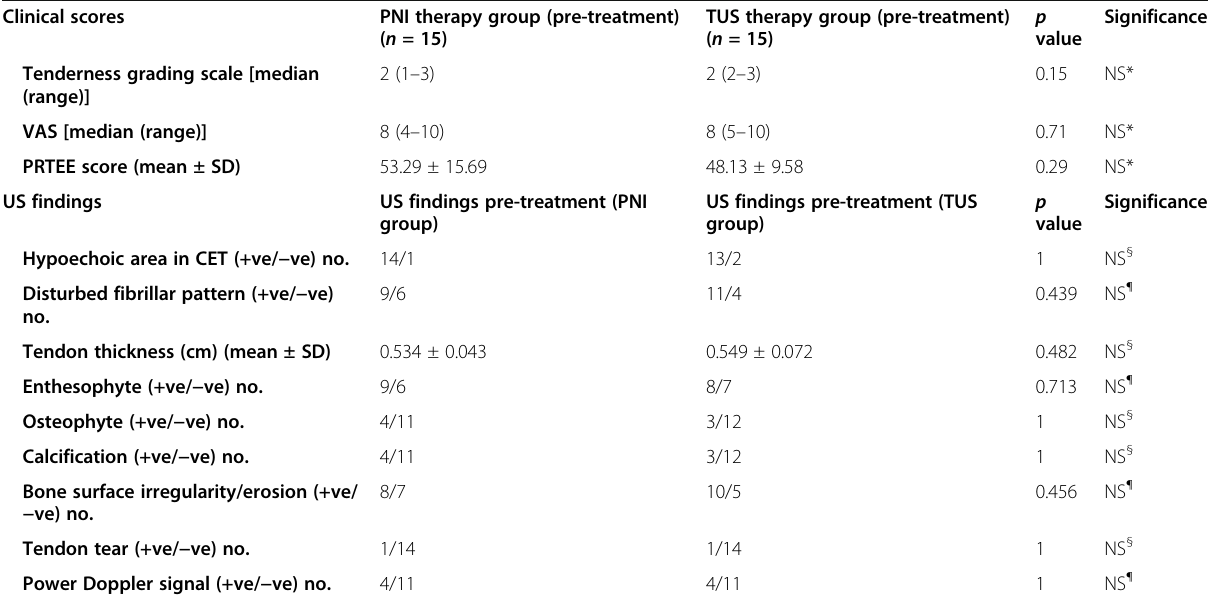
Table 2 Comparison of tenderness grading scale, pain intensity measured by VAS scale, PRTEE score, and US findings before treatment in both groups Clinical scores PNI therapy group (pre-treatment)